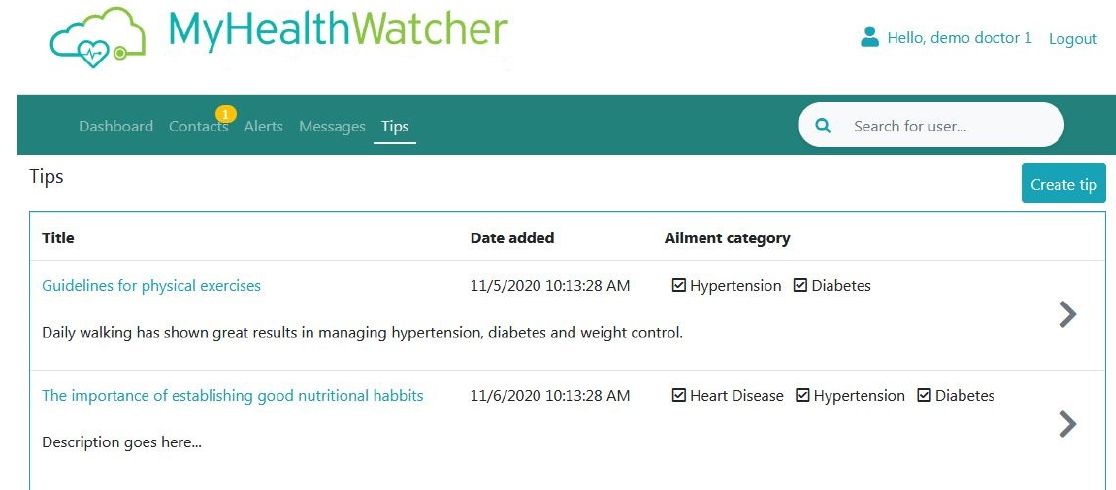
Figure 19. Screenshot of Tips view page—current UI implementation.